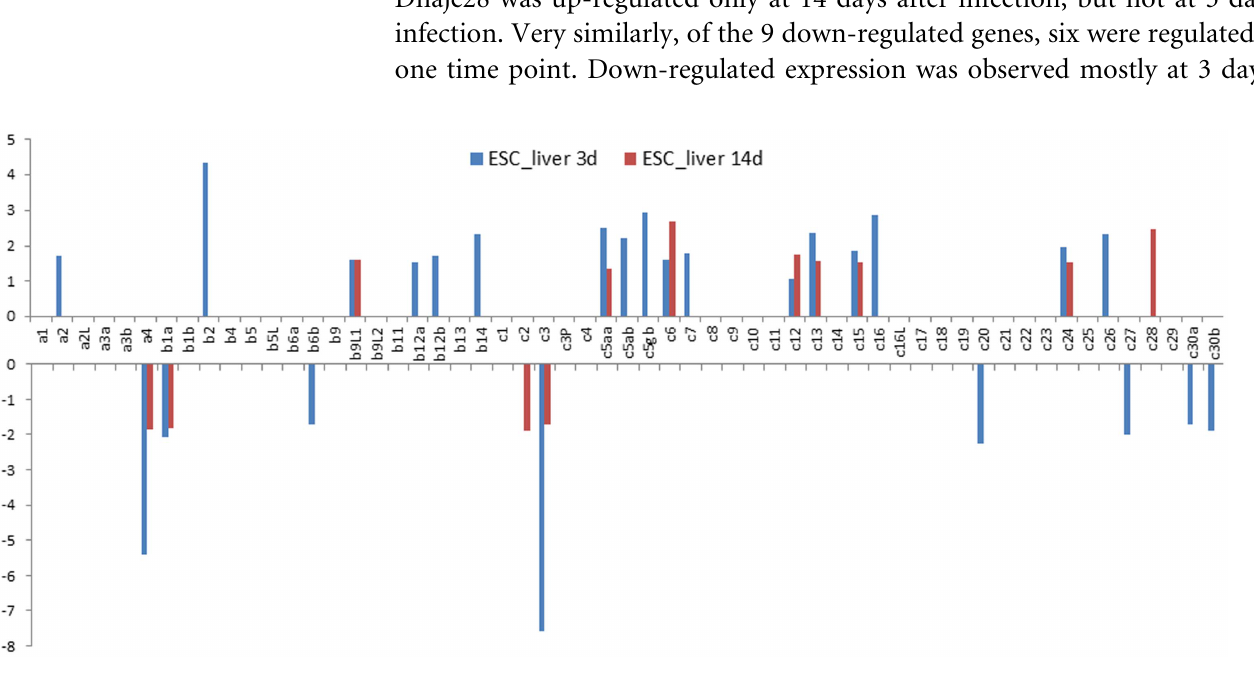
Fig. 7. Column bar chart shows the fold change of Hsp40s expression in liver after E. ictaluri challenge experiments. Vertical axis shows the value of fold change. Gene names are shown as clipped name without ‘‘dnaj’’. For instance, a1 means ‘‘ dnaja1 ’’. ‘‘c3P’’ represents ‘‘ dnajc3_prkri